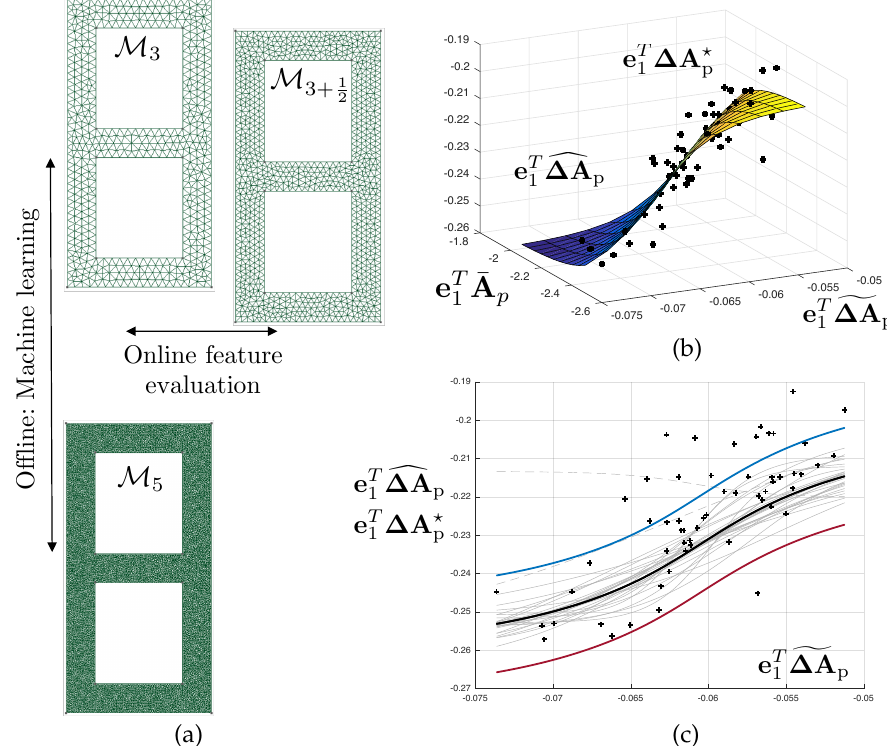
Figure 6. Machine-learning-based error estimation procedure. The overkill error (difference between the current mesh and a much finer mesh as shown in ( a )) is postulated as being an unknown function of an error estimate. The inexpensive error estimate is the distance between the results obtained when using the current mesh and those obtained when using a slightly refined mesh as shown in. ( b ) The statistical learning is done offline via a Monte-Carlo sampling of the true error (using the prior as sampling density) and the adaptive fitting of a Neural Network regression. The regression is bootstrapped to provide enhanced stability, and derive confidence interval estimates for the overall error estimation procedure which is shown in ( c ). Both the size of the dataset and the hyperparameters of the network are found automatically via a Greedy process that is not detailed in this